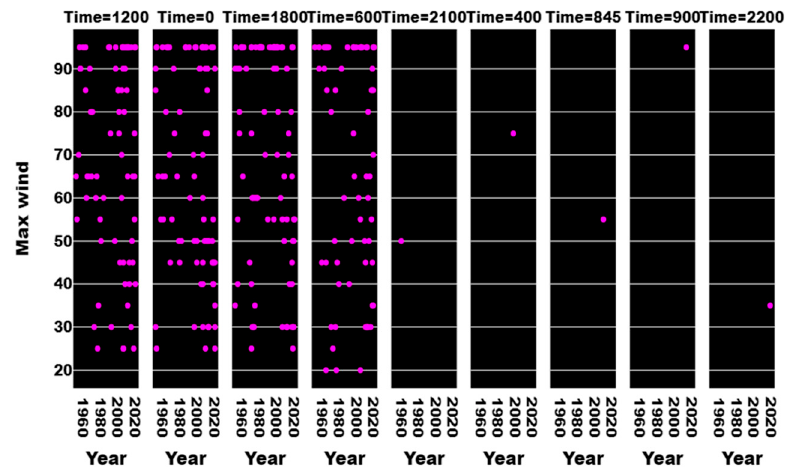
Figure 3. Storms with respect to time, year, and maximum wind speed.